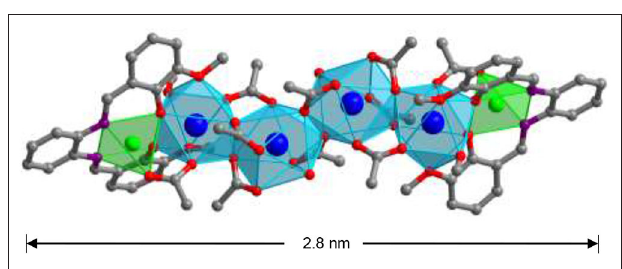
FIGURE 1 | The X-ray crystal structure of 1 (Nd 3 + : blue, Zn 2 + : green).